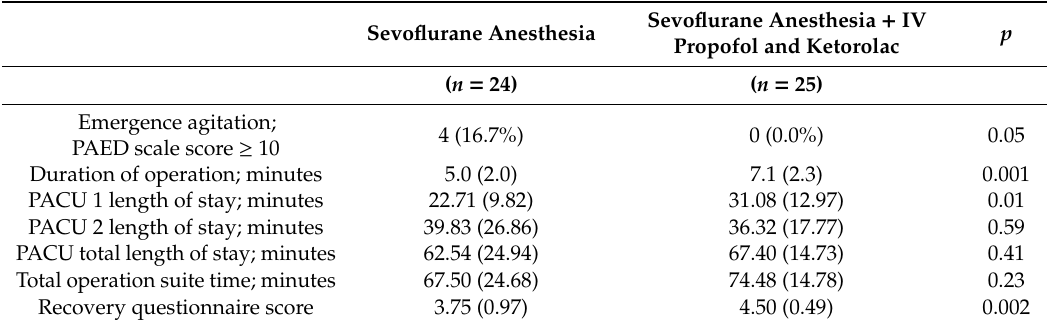
Table 3. Patients experiencing emergence agitation after bilateral myringotomy and tympanostomy tube insertion and secondary outcomes categorized by type of anesthetic provided. Values are number (proportion) or mean